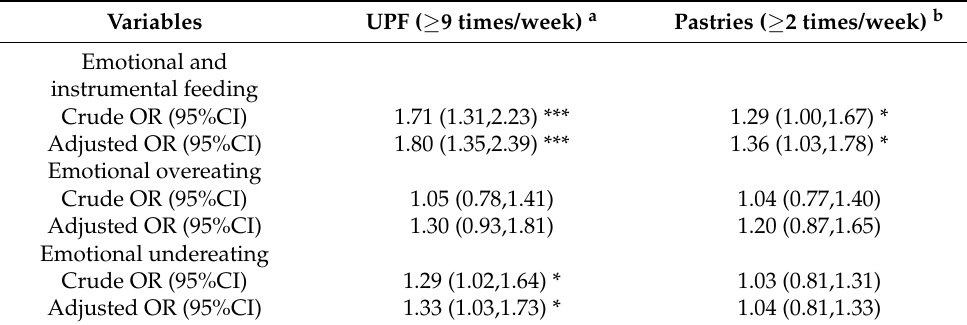
Table 4. The associations between children’s frequencies of UPF consumption and caregivers’ emo- tional and instrumental feeding, as well as children’s emotional eating ( n =